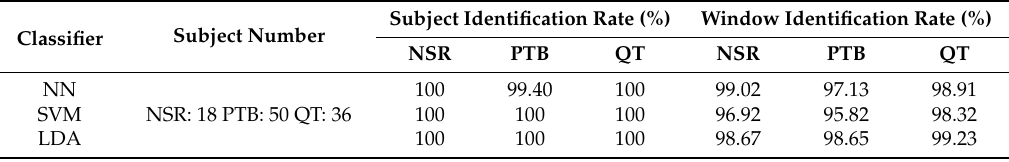
Table 2. Results of proposed method. NN: nearest neighbor; SVM: support vector machine; LDA: linear discriminant analysis.